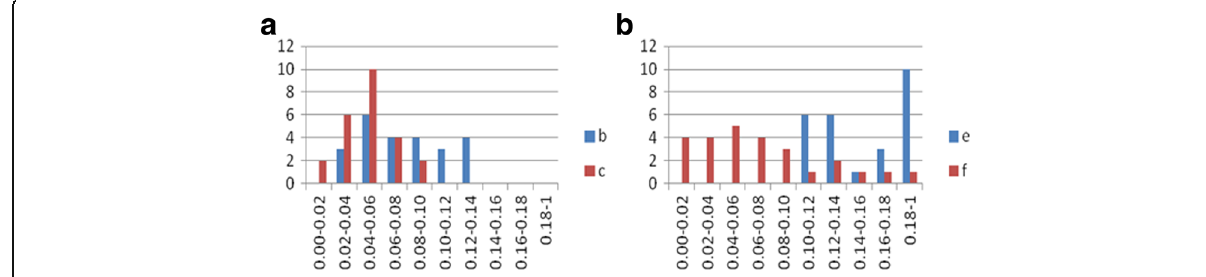
Fig. 16 Histogram of similar distance. a Histogram of results Fig. 15b, c. b Histogram of results Fig. 15e,